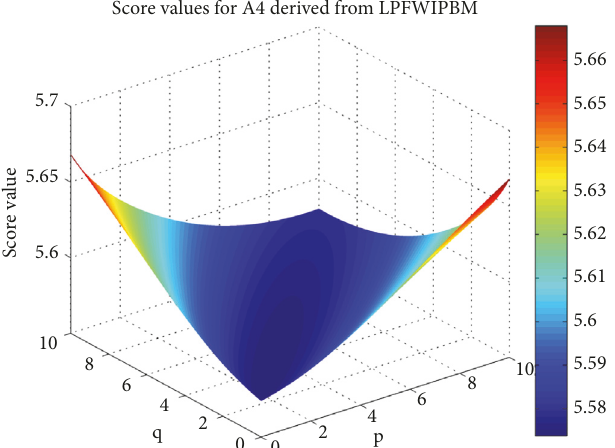
Figure 5: Score values of alternative A4 derived from LPFWIPBM when 𝑝, 𝑞 ∈ (0,10) .